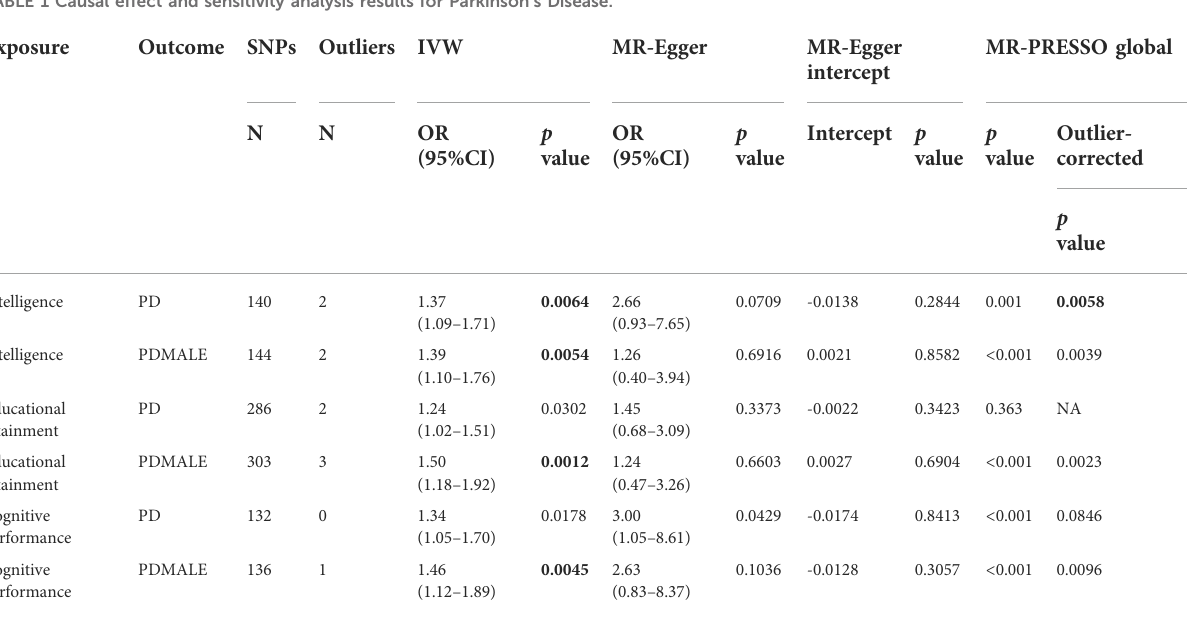
TABLE 1 Causal effect and sensitivity analysis results for Parkinson ’ s Disease.